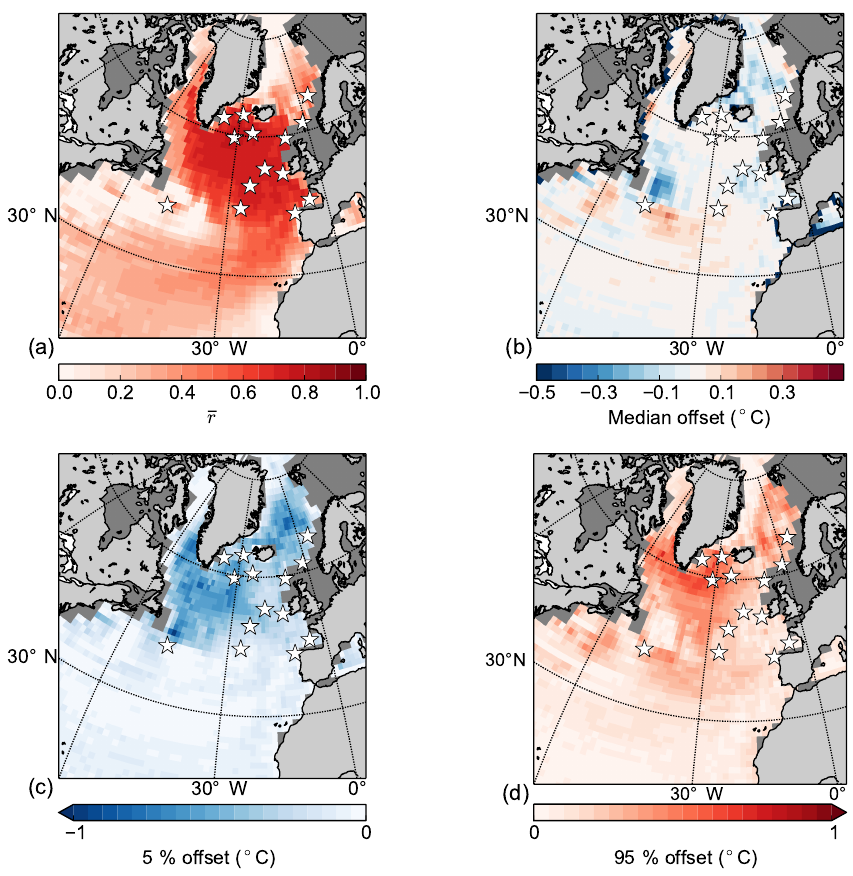
Figure 3. Synthetic PSR study. Colors show the (a) mean correlation coefficient between the synthetic data and the surrogate reconstruction, (b) the median, (c) the 5 and (d) 95% offsets between the synthetic value and the reconstructed surrogate value. The synthetic observations are 30 random years from the CCSM4 model pool at the core locations; the model pool is HadCM3. This is repeated 1000 times. Grey shading represents the glacial coastline in the tcmoe3 simulation (Table 2, differs slightly between runs), while the white stars mark the core